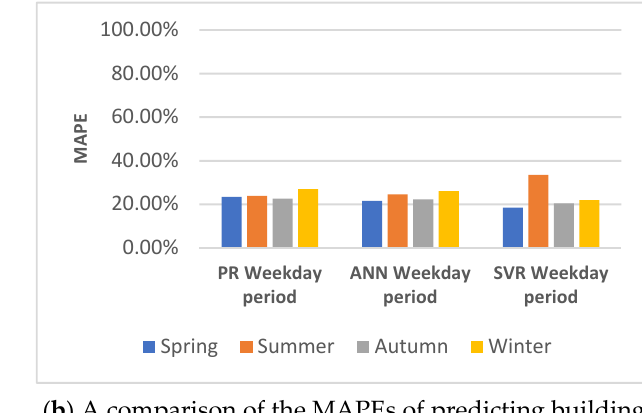
( b ) A comparison of the MAPEs of predicting building weekday period energy usage with PR, ANN and SVR models trained with unsegmented training data. Figure 21.